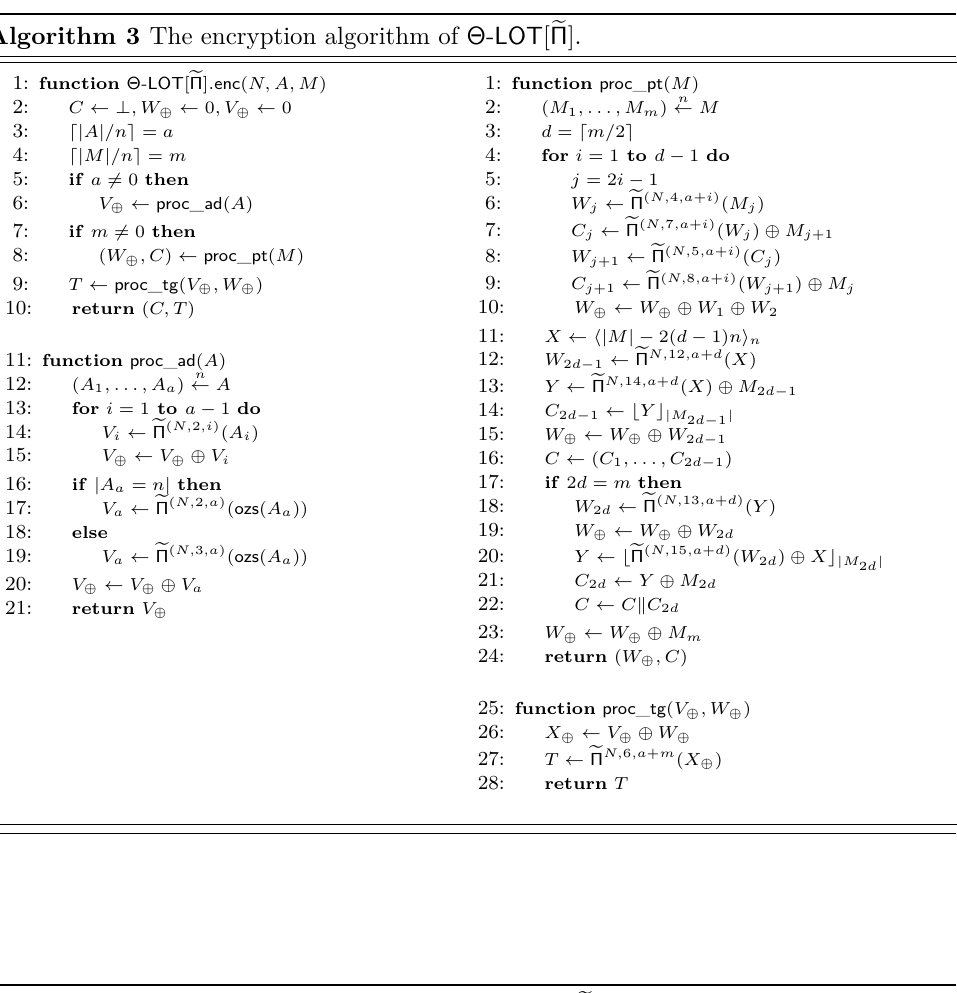
Algorithm 4 The encryption algorithm of Θ-LOC [ e Π ]. The subroutine proc _ ad and proc _ tg are identical to the one used in Θ-LOT [ e Π